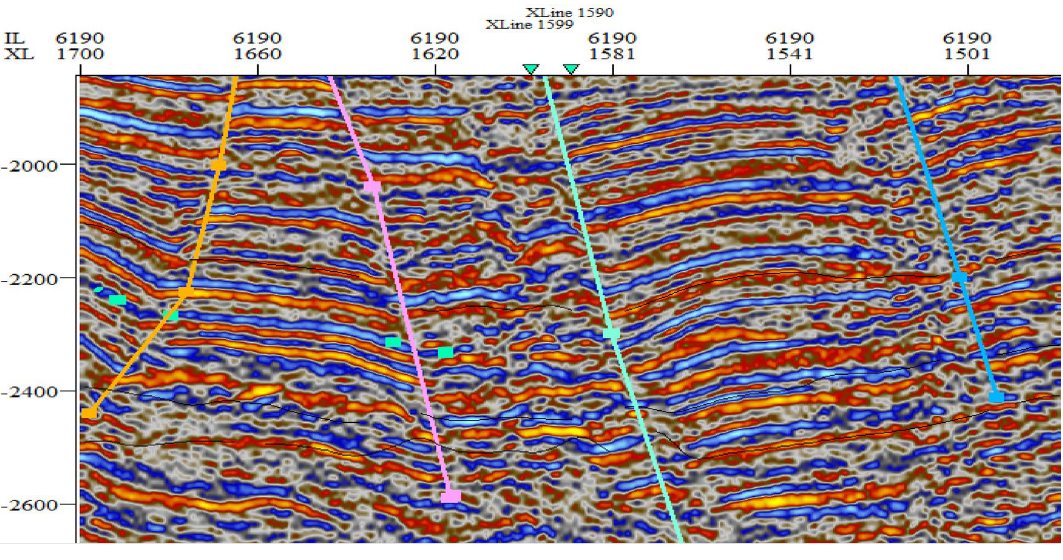
Fig. 7 Typical interpreted seismic section (Inline